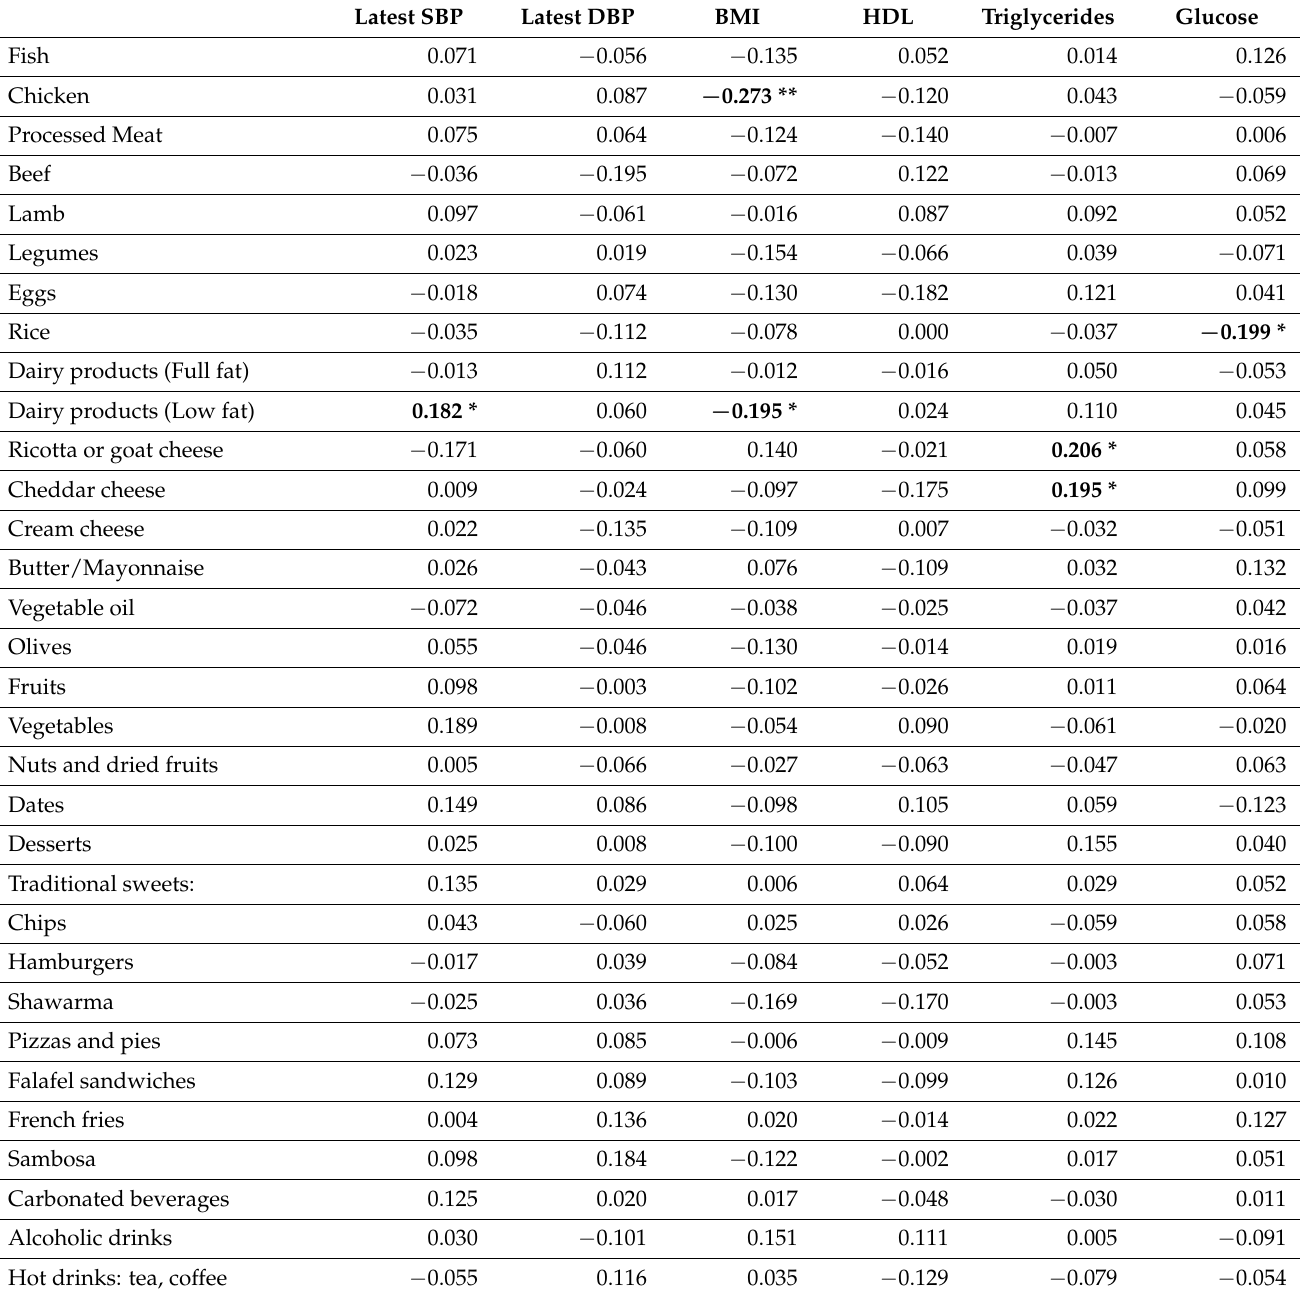
Table 2. Spearman’s partial correlation analysis with